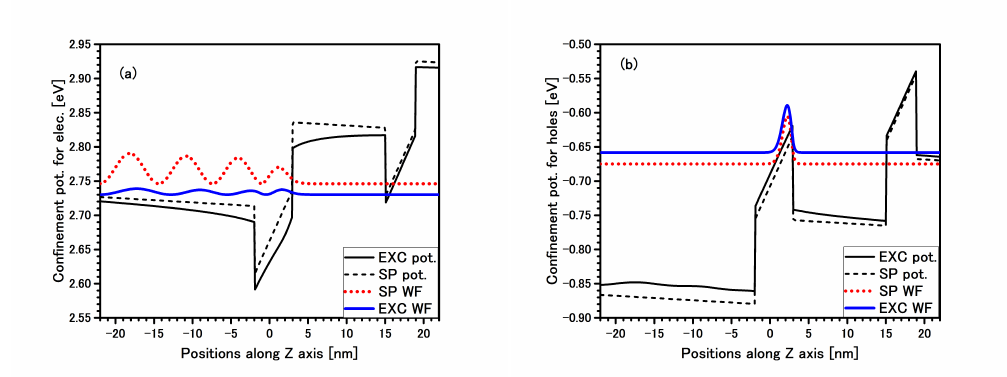
Figure 3. Band edge profile potentials (black lines) with single particle (SP) wave-function (WF) (dotted red line) and excitonic multiplier of the WF (solid blue line) for electron ( a ) and hole ( b ) for extended EL1 exciton in QW 5nm are presented in the structure #1. Solid black lines are confined potential with additional Coulomb term (Equation (7)).